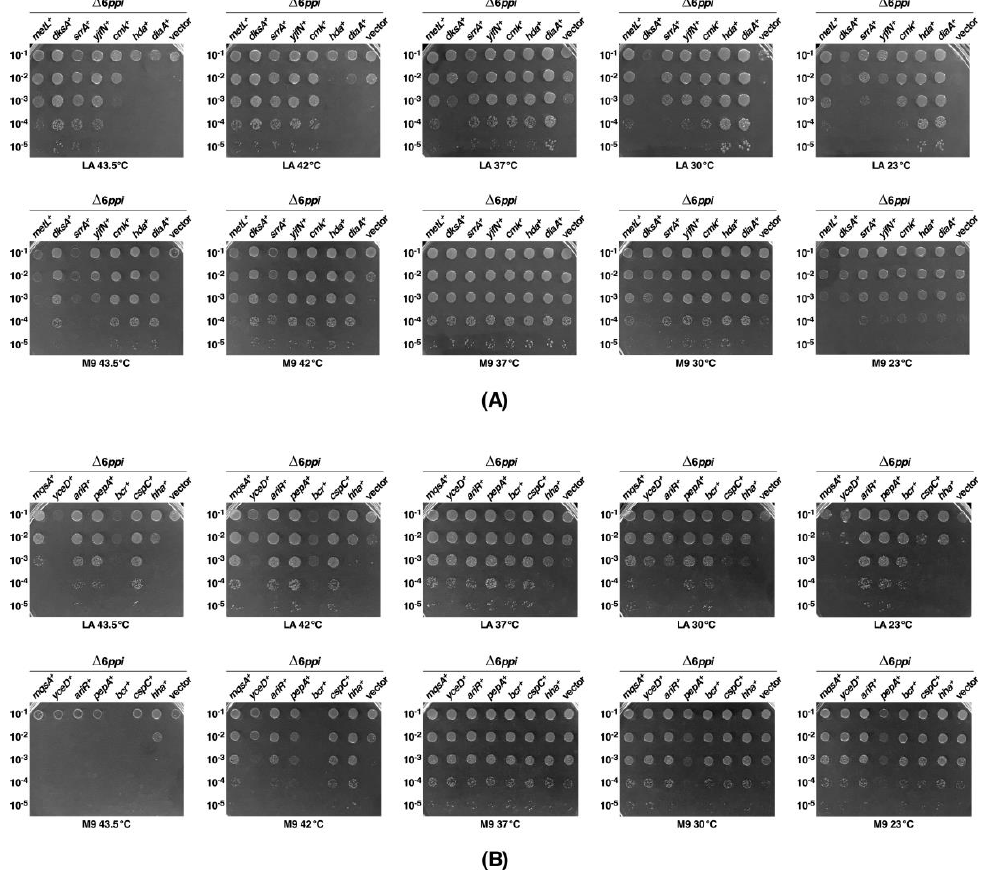
Figure 3. Identification of genes whose overexpression can restore the growth of ∆ 6 ppi bacteria at di ff erent temperatures. Exponentially grown cultures of the wild type and its isogenic ∆ 6 ppi derivatives transformed with either the vector pCA24N or the same vector expressing a specific gene under the control of IPTG-inducible promoter were grown at 37 ◦ C in M9 minimal medium. Cultures were washed and adjusted to an optical density OD 600 of 0.1 and serially spot diluted on M9 minimal medium and LA medium in the presence of 75 µ M IPTG. ( A , B ) The growth of di ff erent strains expressing a specific gene with the indicated genotype, whose overexpression confers a varying degree of suppression depending upon temperature of incubation and growth medium. Table 2. Multicopy suppressors that restore the growth of Δ6 ppi strains under different conditions.